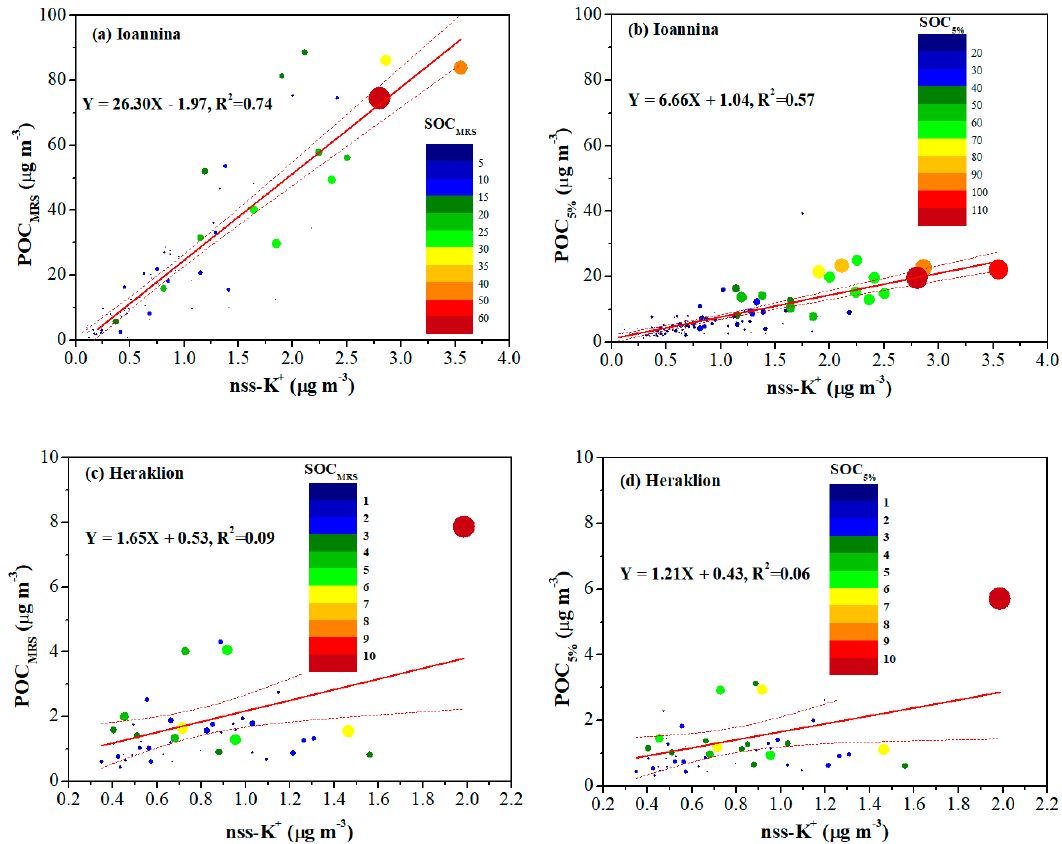
Figure 5. Correlations between nss-K + and POC estimates via the MRS and 5% percentile methods in Ioannina ( a , b ) and Heraklion ( c , d ), as a function of the respective SOC